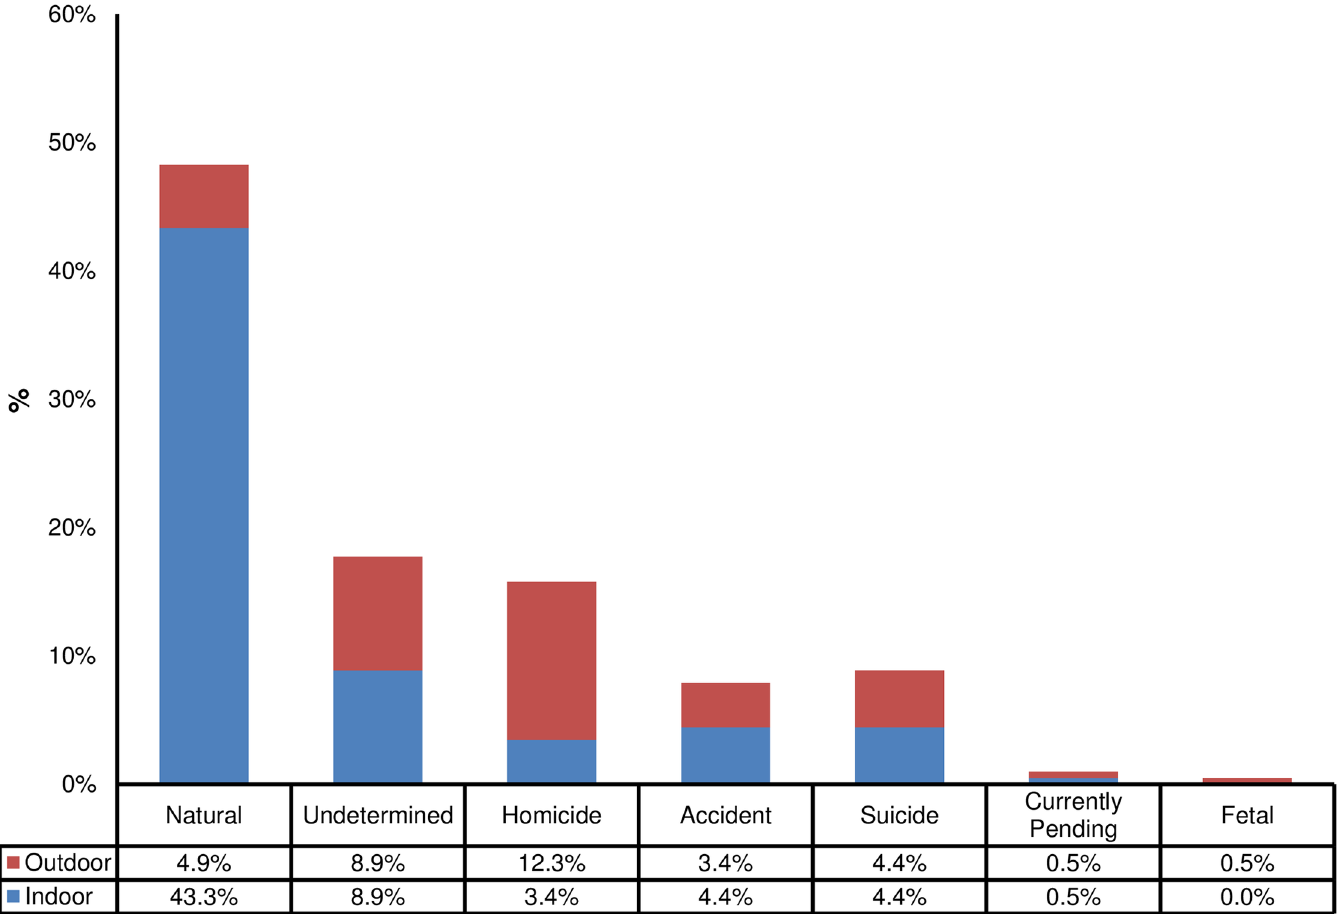
Fig 1. Forensic entomology casesby official manner of death and scene location. Percentageof forensic entomology cases over the study period (January 2013—April 2016) by official manner of death classification,showingthe proportionof cases where the scene was locatedindoors (blue) or outdoors (red). (N =